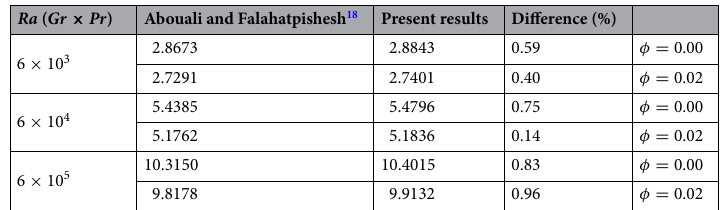
Table 3. Comparison of the average Nusselt number obtained from the present numerical simulations with the correlation results of Abouali and Falahatpishesh 18 for different values of Rayleigh number.